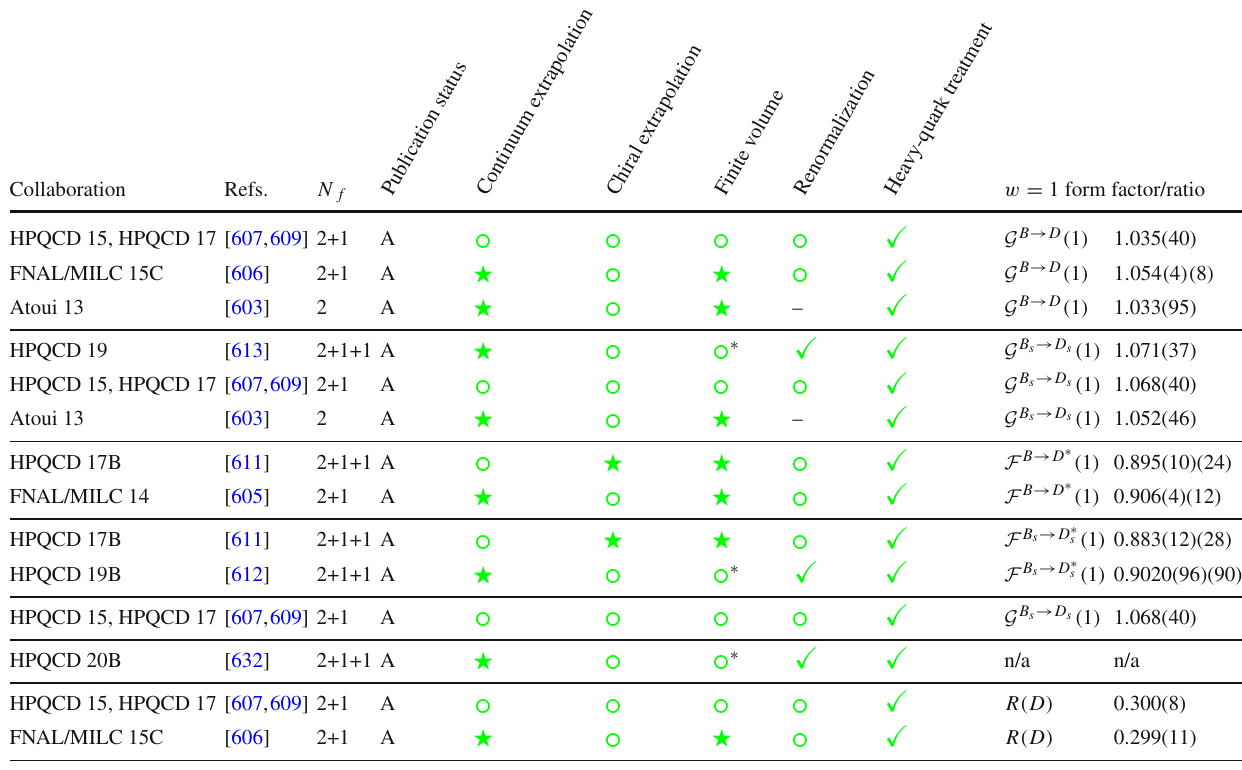
Table 54 Lattice results for mesonic processes involving b → c transitions